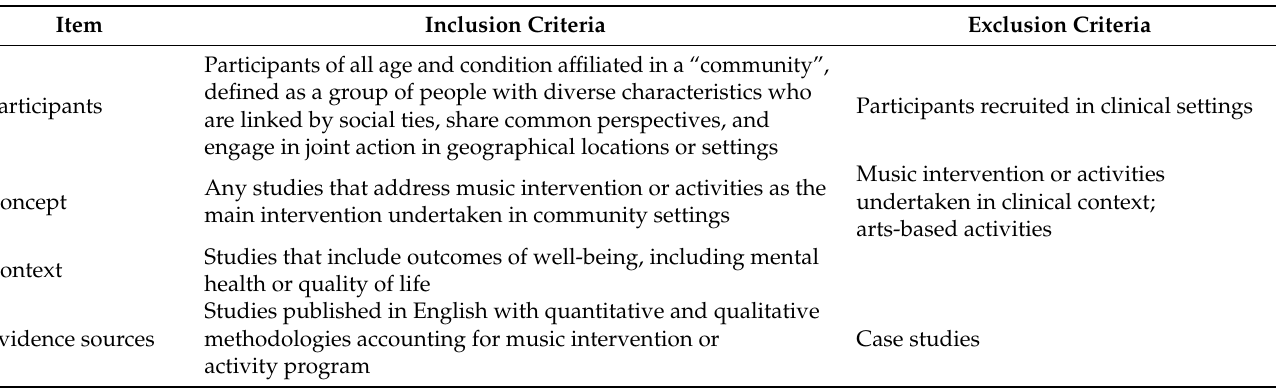
Table 1. Inclusion and exclusion criteria for literature